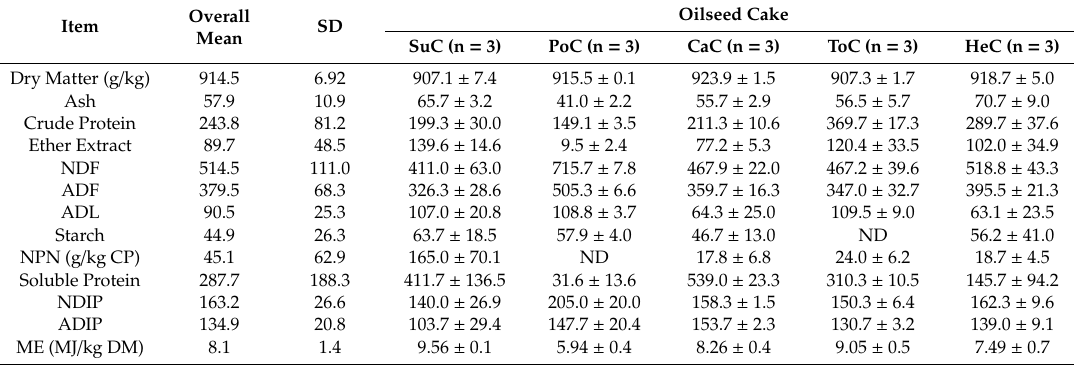
Table 1. Chemical composition (g / kg dry matter, DM, if not otherwise stated) of the oilseed cakes (mean and standard deviation of 3 di ff erent cake